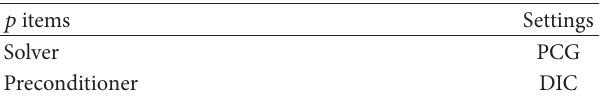
Table 2: Solver and preconditioner used for solving 𝑝 of the linear algebraic